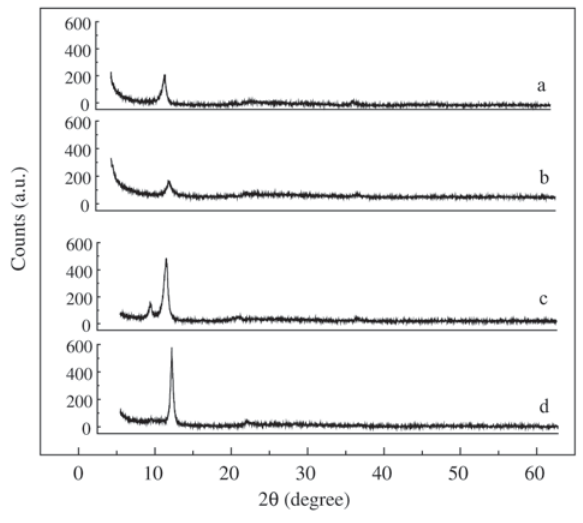
Figure 5. X-ray diffraction patterns of a) ZrP(h, 50); b) ZrP(h, 300), c), ZrP(t, 50), d) ZrP(t,